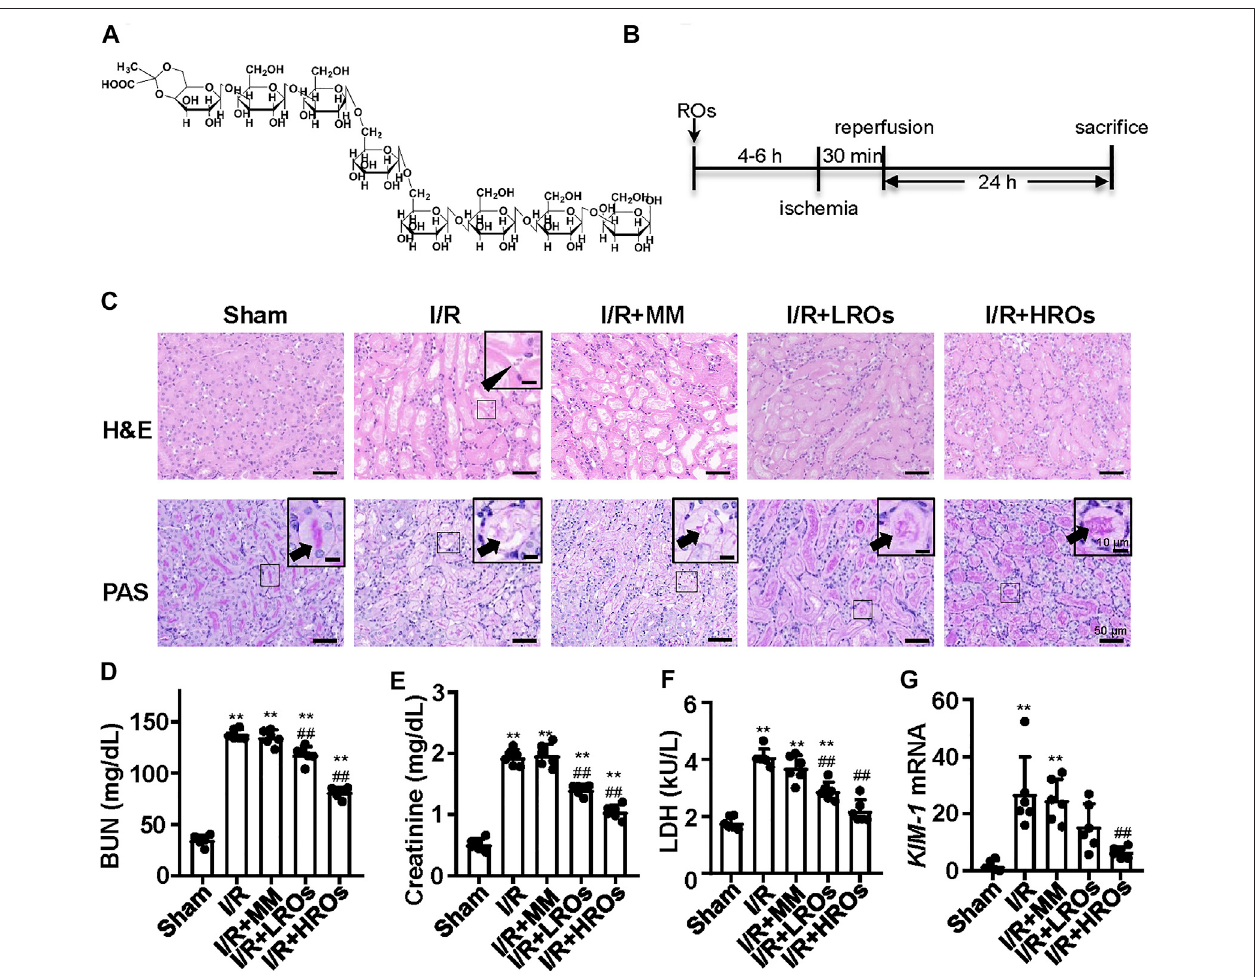
FIGURE 1| Functional and morphological protection from renal IRI with riclinoctaose at 24 h after reperfusion. (A) Chemical structure of riclinoctaose. (B) Schema for invivo experiments.C57BL/6miceunderwentshamorI/Roperation.I/Rmiceweretreatedwithaperitonealinjectionofvehicle,monosaccharidemix(MM:galactose 5 mg/kgandglucose35 mg/kg),orriclinoctaose(LROs:20 mg/kg;HROs:40 mg/kg)4 – 6 hbeforethe30min-ischemiaandsacri fi ced24 hafterreperfusion. (C) Upper panel: representative kidney section stained for hematoxylin and eosin (H and E) in each mice group. Arrowhead indicates cell debris. Lower panel: representative kidneysectionstainedwithPeriodicacid – Schiff(PAS)ineachmicegroup.Arrowheadsindicatebrush border. (D-F) Bloodureanitrogen (BUN)levels(D),serumlevelsof creatinine (Cre) (E), and lactate dehydrogenase (LDH) (F) in each mice group. (G) Kim1 mRNA levels in kidneys of the four groups of mice. ROs: Riclinoctaose. Data are expressed as mean ± SD. n (cid:1) 6, * p < 0.05, ** p < 0.01 compared with the sham group; # p < 0.05, ## p < 0.01 compared with the I/R group. Data were analyzed by the two-way ANOVA followed by Bonferroni post hoc analysis.